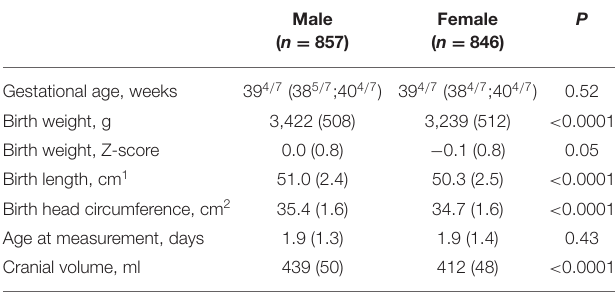
TABLE 1 | Neonatal